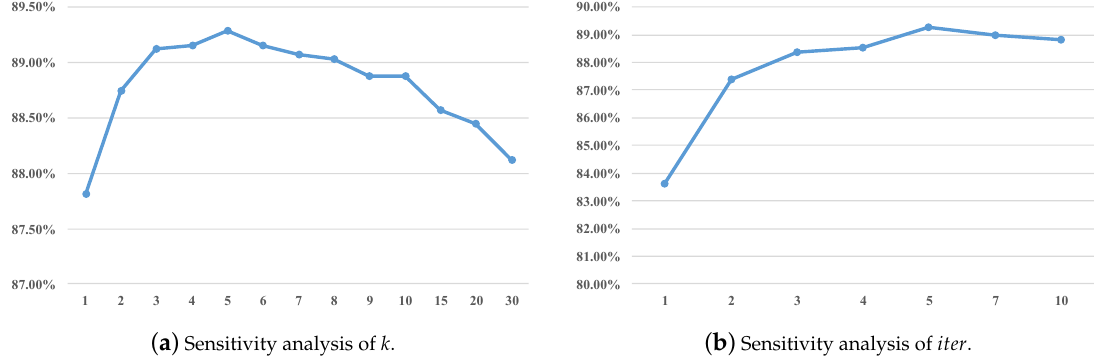
Figure 5. Sensitivity analysis. X-axis: the value of the parameters. Y-axis: the mean accuracy (%) on two